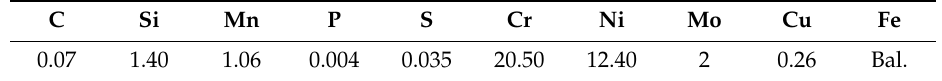
Table 1. Chemical composition of 316 AISI modified stainless steel (wt%).